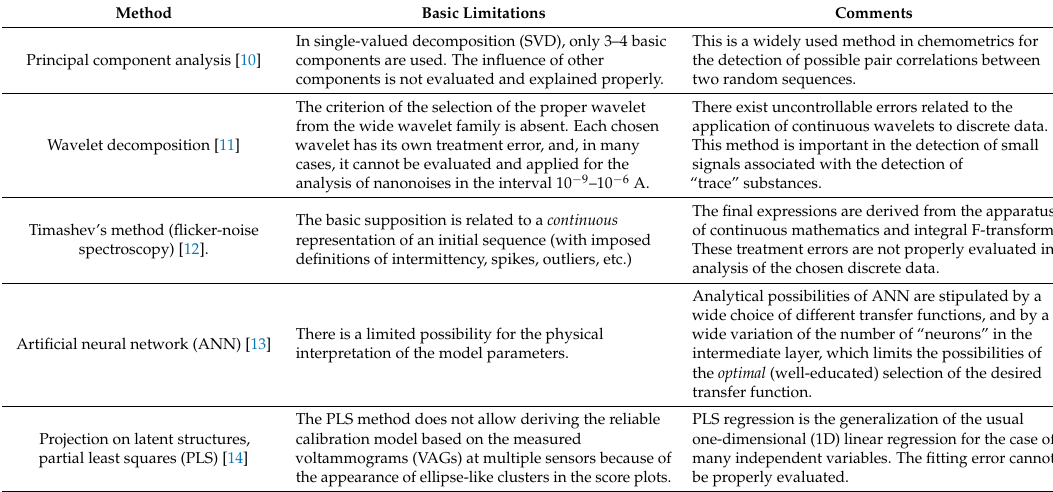
Table 1. The basic methods used in electrochemistry for the detection of small additives.